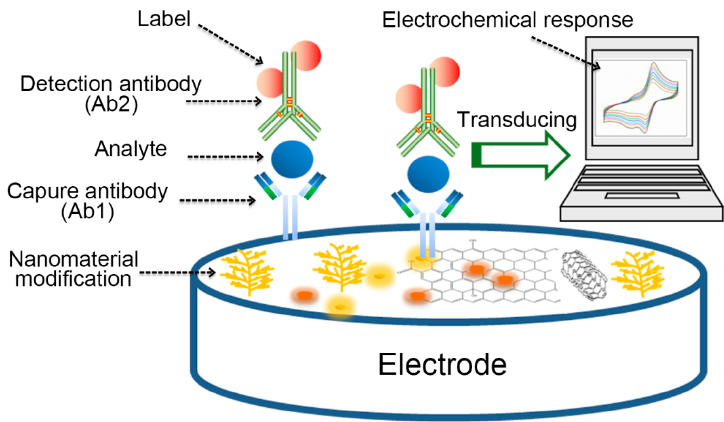
Figure 1. A schematic representation of electrochemical immunosensor.